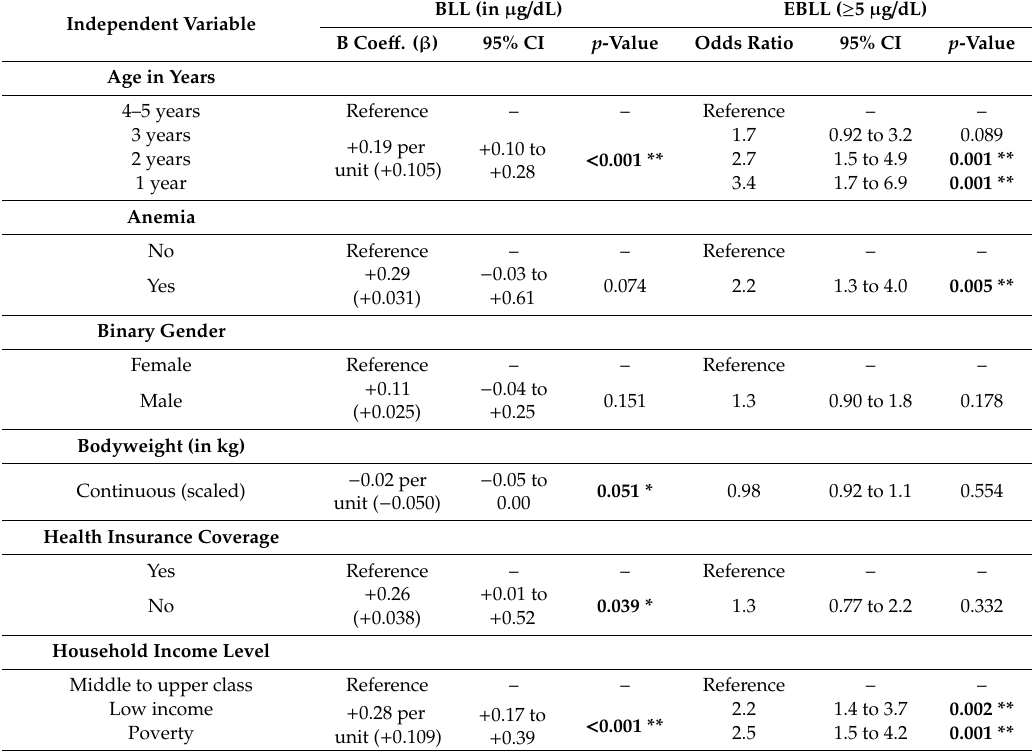
Table 2. Continuous blood lead levels (BLLs) or an elevated BLL (EBLL) ≥ 5 µ g / dL after correcting for risk factors and other covariates in full multiple regression model analysis—the 1999 to 2010 NHANES. Independent